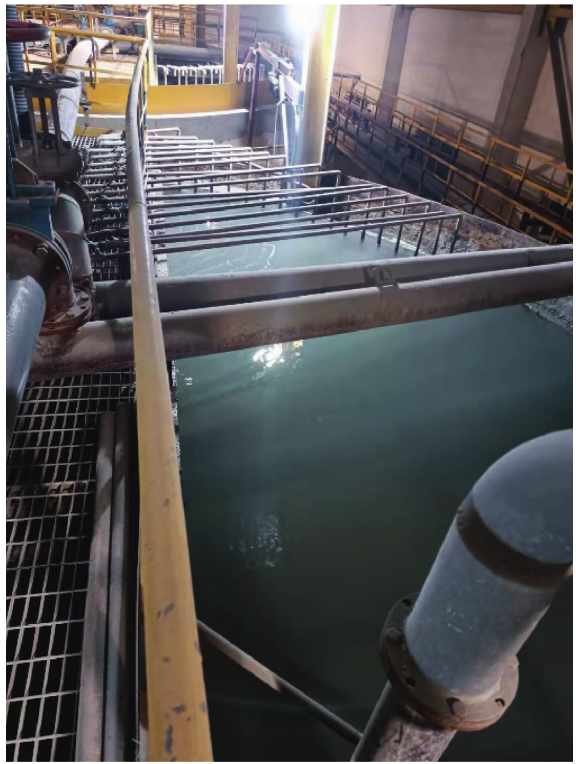
Figure 8: Overflow water.